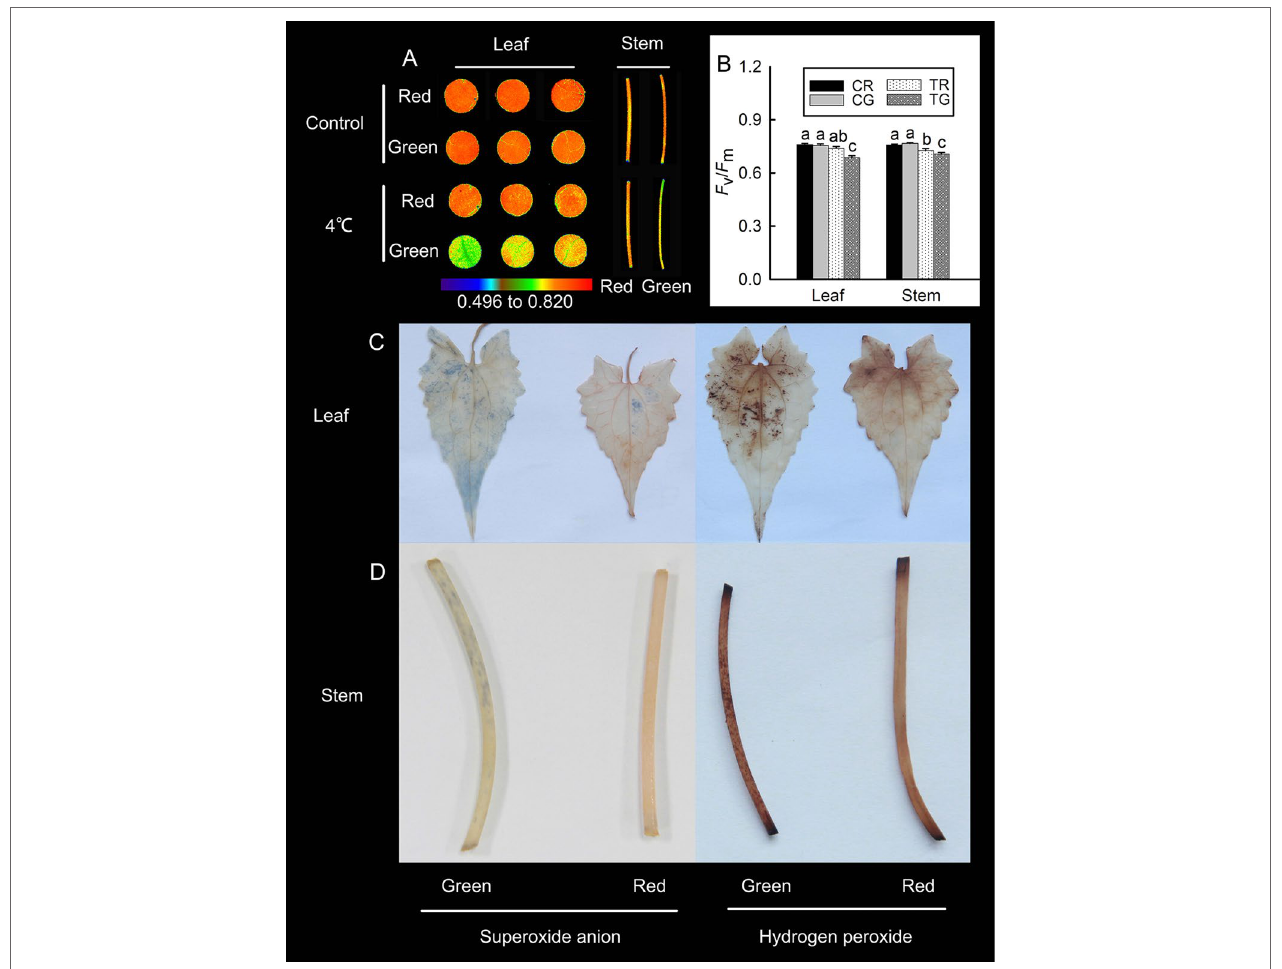
FIGURE 2 | Changes in the maximum photochemical efficiency ( F v / F m ) of the red leaves (RL), red stems (RS), green leaves (GL), and green stems (GS) of M. micrantha after 4°C treatment (A) , the F v / F m value of red and green in control (CR, CG) and 4°C treatment (TR, TG) (B) . Tissue localization of superoxide anions and hydrogen peroxide in the RL, RS, GL, and GS of M. micrantha was observed after 4°C treatment (C , D) . The error bars represent the standard errors (SEs) of three biological replicates. One-way analysis of variance (ANOVA) was used to evaluate the statistical significance; the bars with different letters (a, b, c, d) indicate significant differences between the means (least significant difference LSD, P <